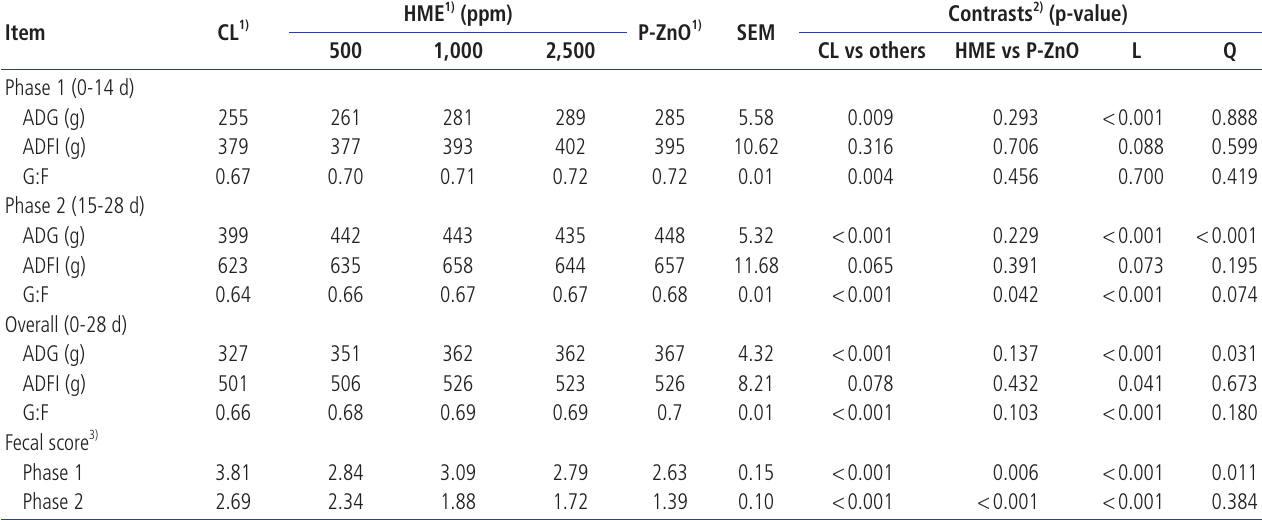
Table 2. Effects of different ZnO sources on growth performance and fecal score in weanling pigs